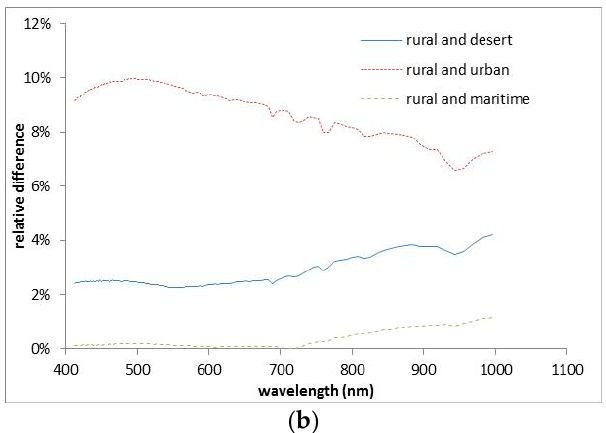
Figure 24. Relative differences in radiance using different aerosol types for the SPARK-02 calibration for 28 February 2017 using ( a ) the reflectance-based method and ( b ) the irradiance-based method. Table 4. Average relative differences in radiance for the SPARK-01 and -02 satellites.